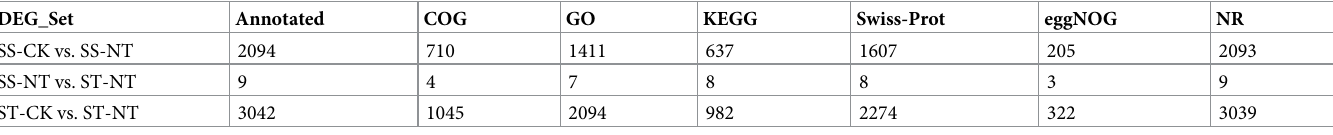
Table 3. Statistics of the number of annotated DEGs. DEG_Set